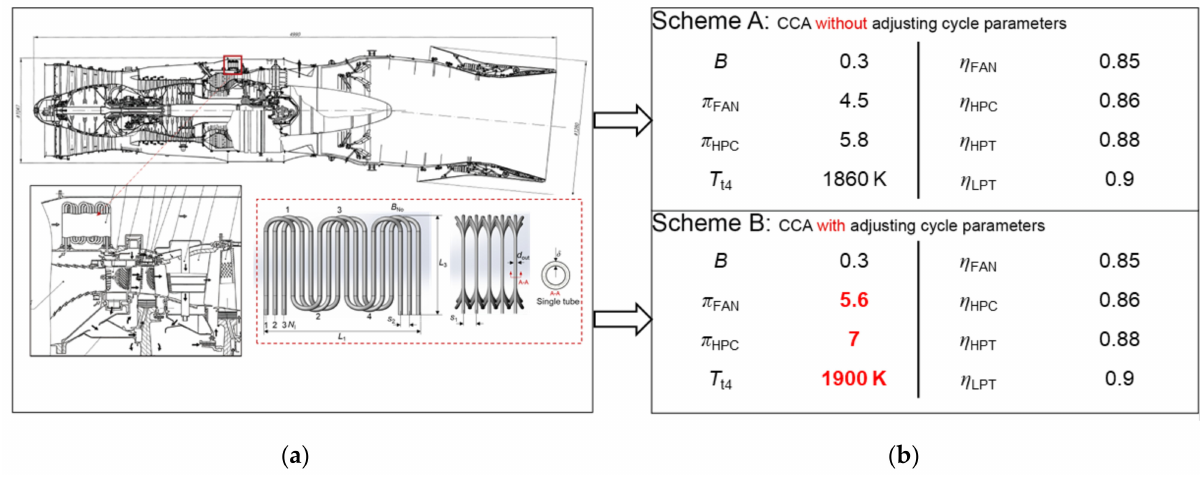
Figure 1. The concept diagram of CCA technology and engine schemes. ( a ) Diagram of CCA technology [27]; ( b ) Cycle parameters of design point. Table 1. The thermodynamics and mass flow rate information for the components in different schemes at design